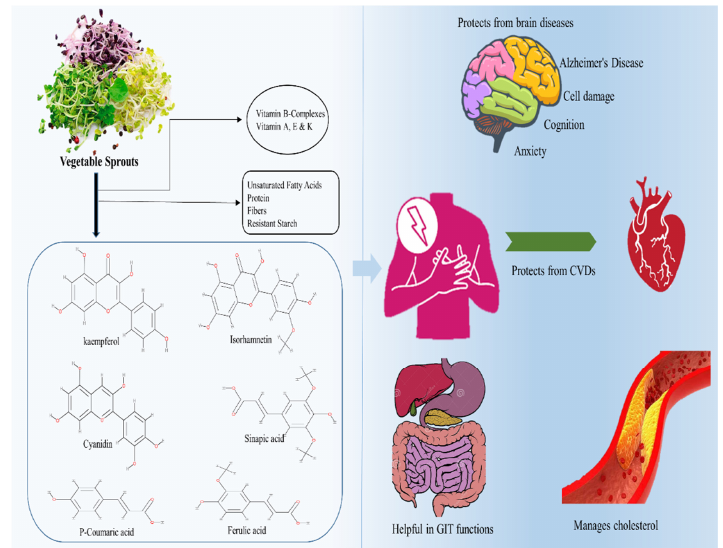
Figure 3. Bioavailability of sprouts against different disorders.